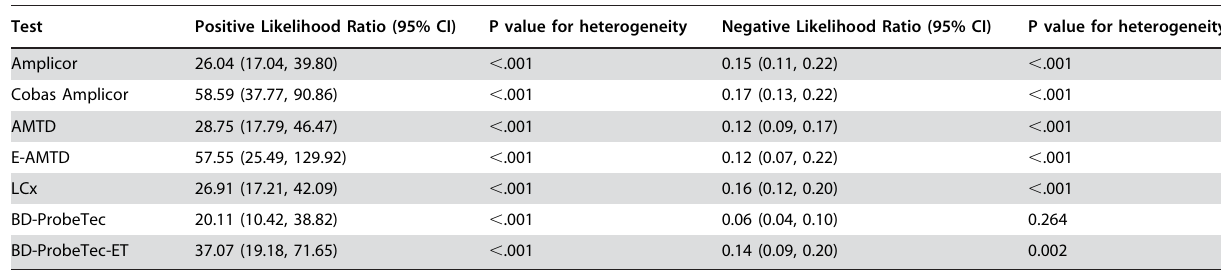
Table 5. Likelihood Ratios Stratified by Commerical NAAT .. ... .... ... ... .... ... ... .... ... ... .... ... ... .... ... ... .... ... ... .... ... ... .... ... ... .... ... ... .... ... ... .... ... ... .... ... ... .... ... ... .... ... ... .